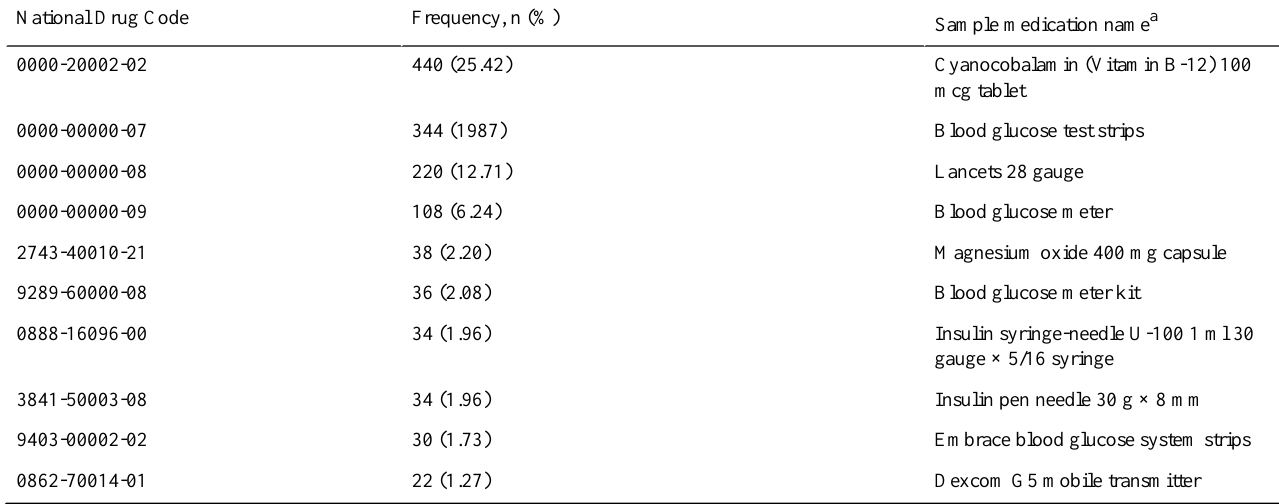
Table 2. Ten most frequent National Drug Codes without a corresponding RxNorm concept unique identifier (n=1731).